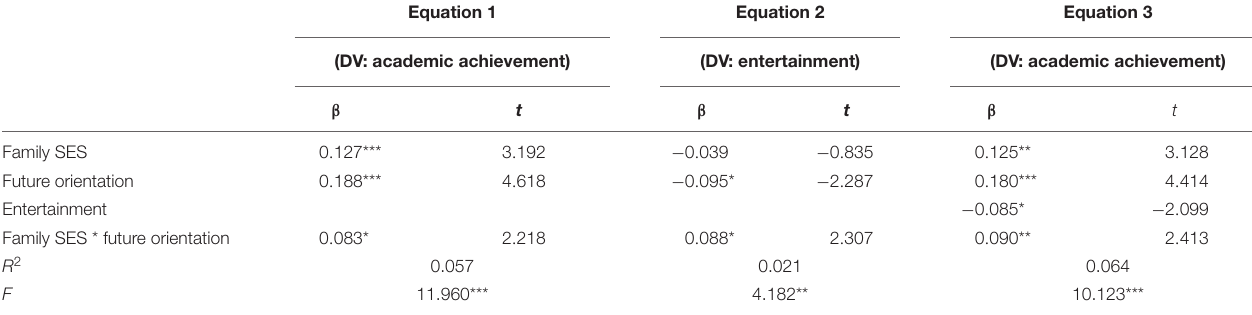
TABLE 2 | Parameter estimates of research models ( N = 596).